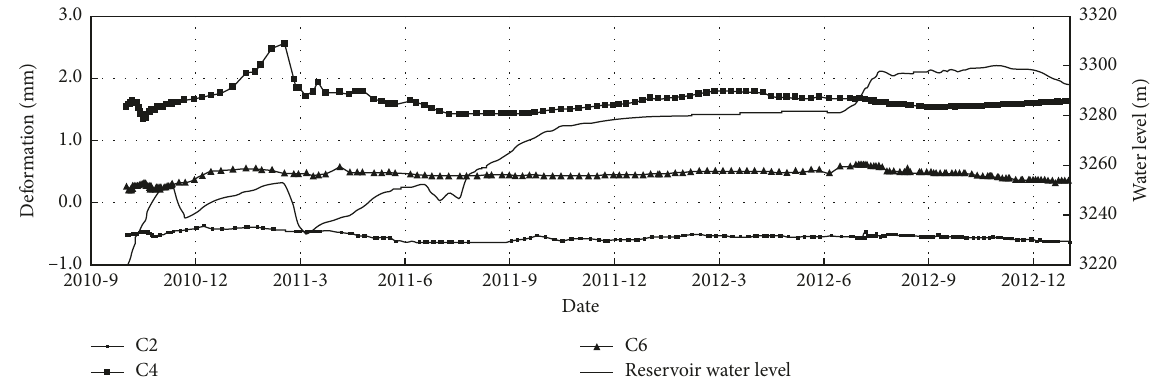
Figure 9: Void deformation time series at the 3255m